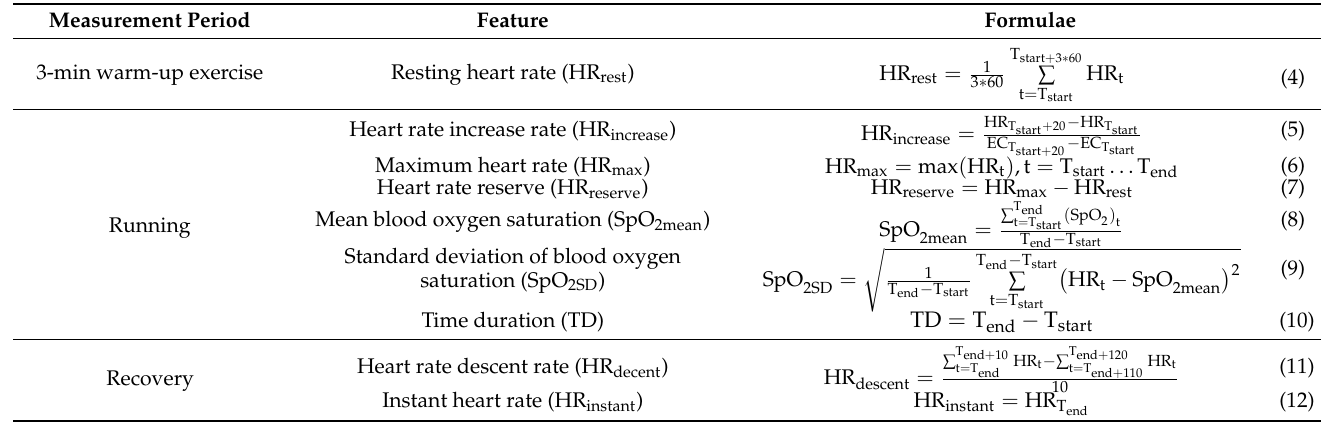
Table 1. Definition formulae of the 9